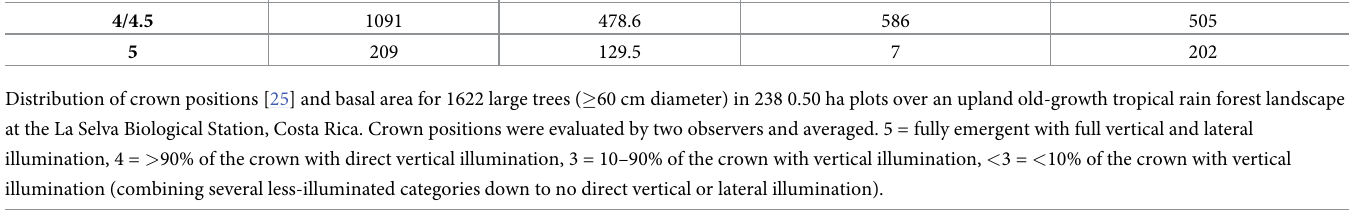
relating the density of large trees to modelled slope and elevation had an r 2 of 0.36 (P < 0.05). In general, large tree density was higher on flatter plots at lower elevations (plot mean elevation range 53–129 masl). The same elevation and slope model applied to the large tree plots showed a similar pattern (r 2 = 0.10, P < 0.001, more large trees in the flatter and lower-elevation plots).